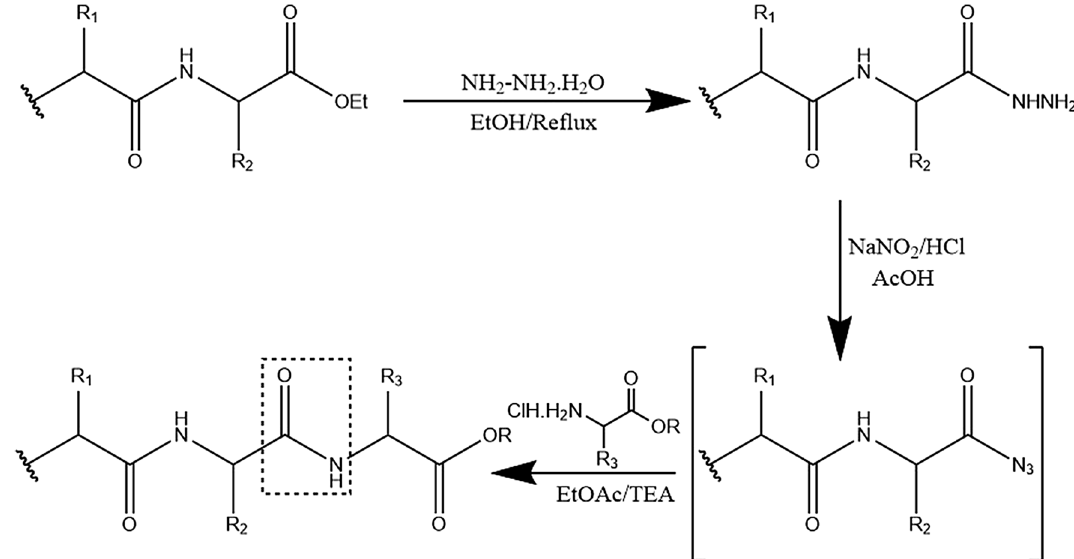
Fig. 2 Installation mechanism of new amino acid ethyl hydrochloride on pyrazolopyrimidine